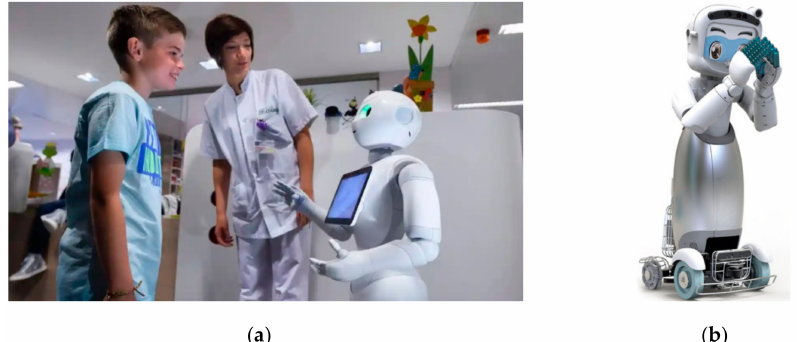
Figure 4. Receptionist robots in hospitals for patient assistance. ( a ) Pepper robot in a Belgian hospital [29]. ( b ) Dinsow 4 robot [30].